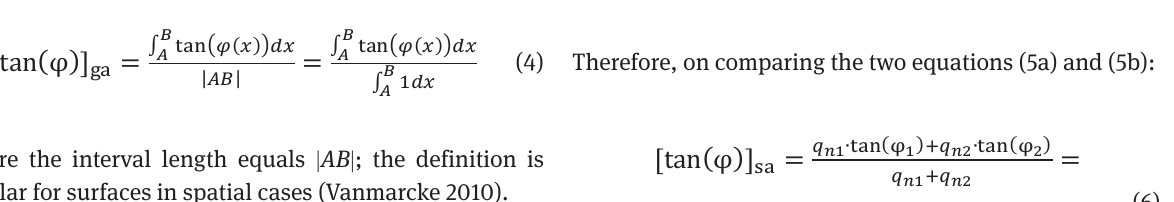
Figure 1: (a) Prototype defined by two random variables tan( j weight coefficient w